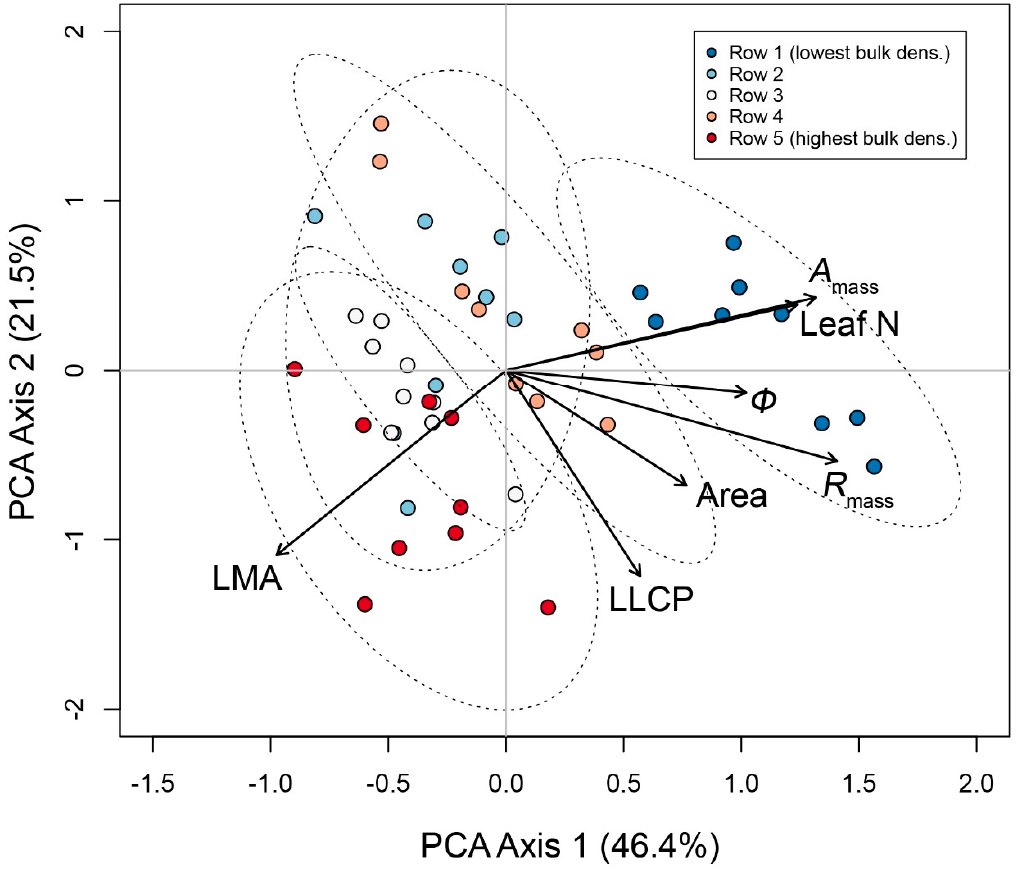
Figure 2. Principal Component Analysis (PCA) for seven ‘Chardonnay’ wine grape leaf traits measured in 2020 across a soil compaction gradient. Data point colours correspond to vine sampling rows, which are situated along a gradient of bulk density values, and dotted black lines represent 95% confidence ellipses for leaves across different rows. Trait acronyms are presented in Table 1.